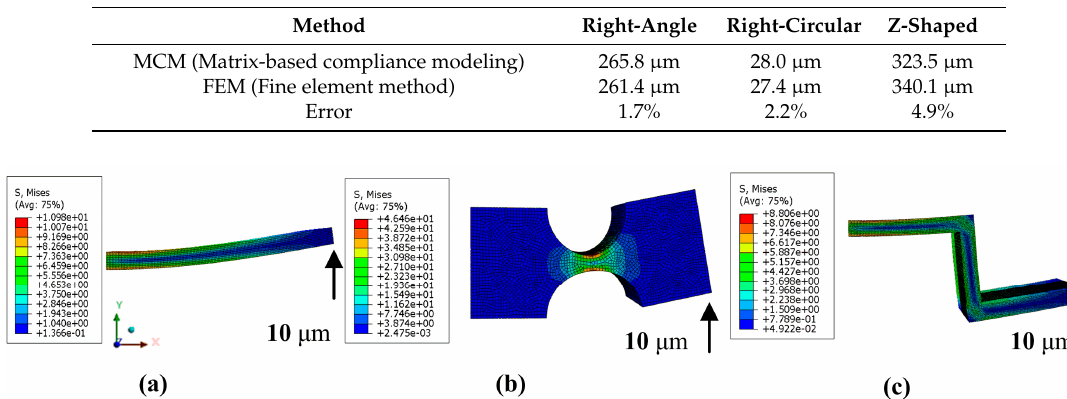
Table 1. Deformation calculation results of three flexure hinges.